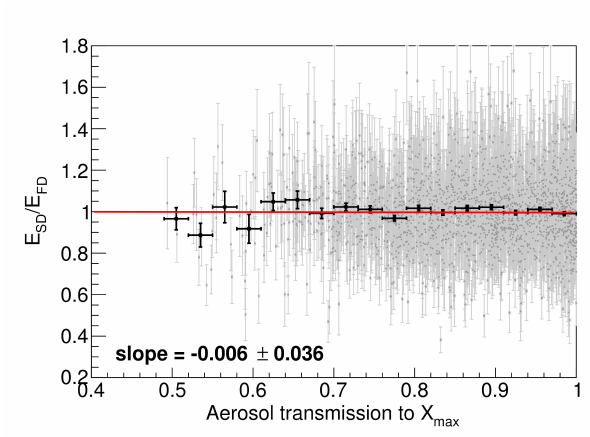
Figure 10. Ratio of the SD to FD energy as a function of the aerosol transmission at X max . The flatness proves the validity of the corrections